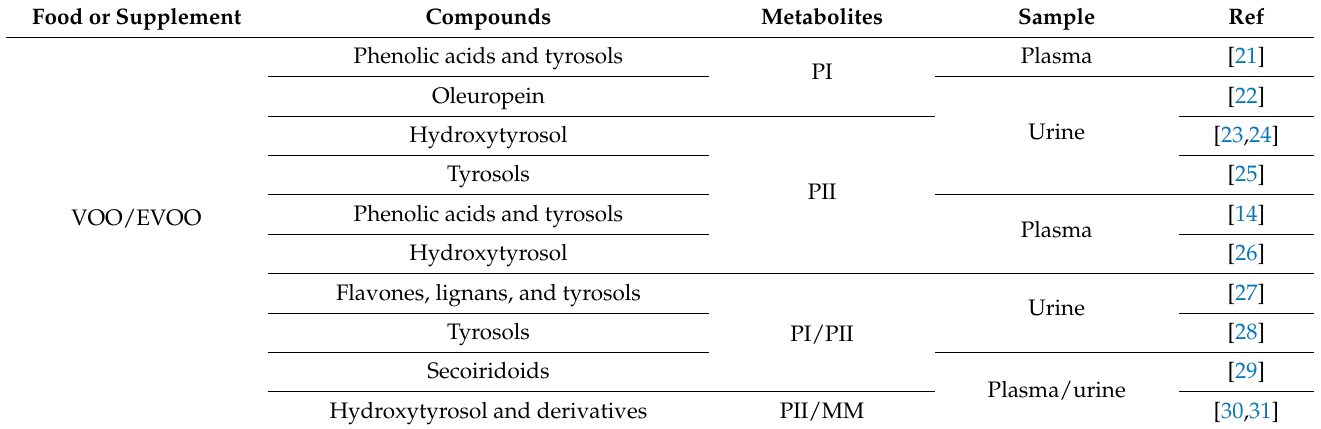
Table 1. Food source of phenolic compounds and the predominant phenolic compound metabolites identified in plasma and urine samples. Food or